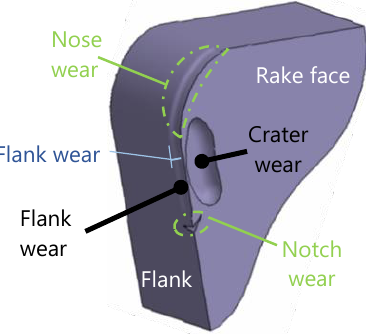
Figure 2. Principal locations and types of wear.